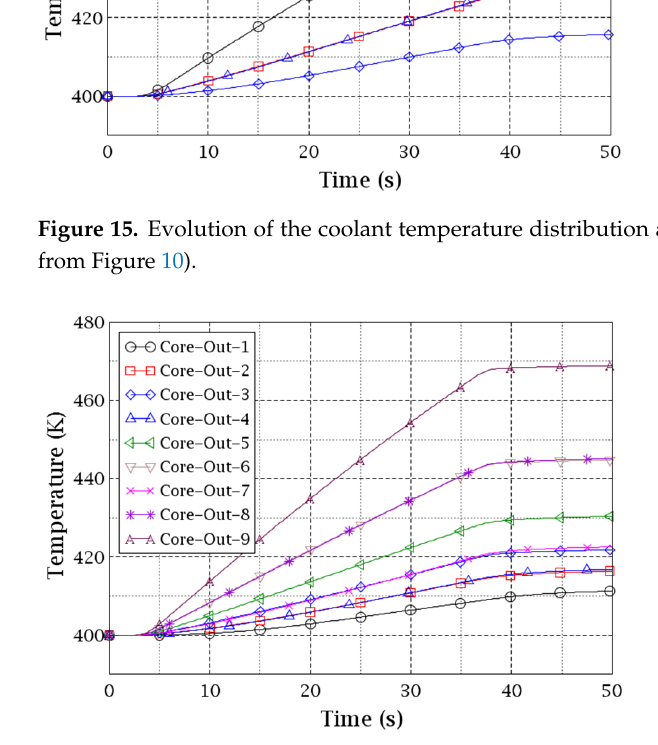
Figure 16. Evolution of the coolant temperature distribution at the core outlet CA-V (cell index is from Figure 10).